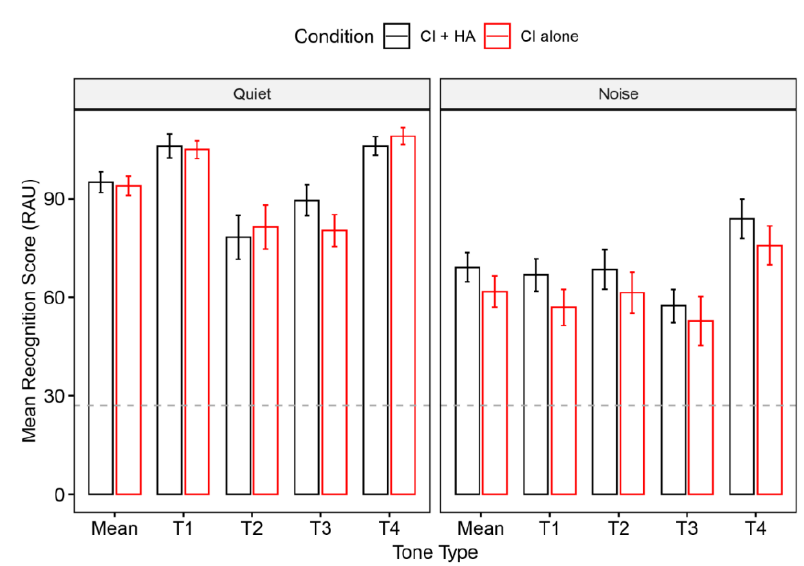
Figure 3. Mean recognition scores in rationalized arcsine unit (RAU) of each tone type in quiet and noise. The dash lines indicate the chance level. Error bars represent the standard errors across all participants.